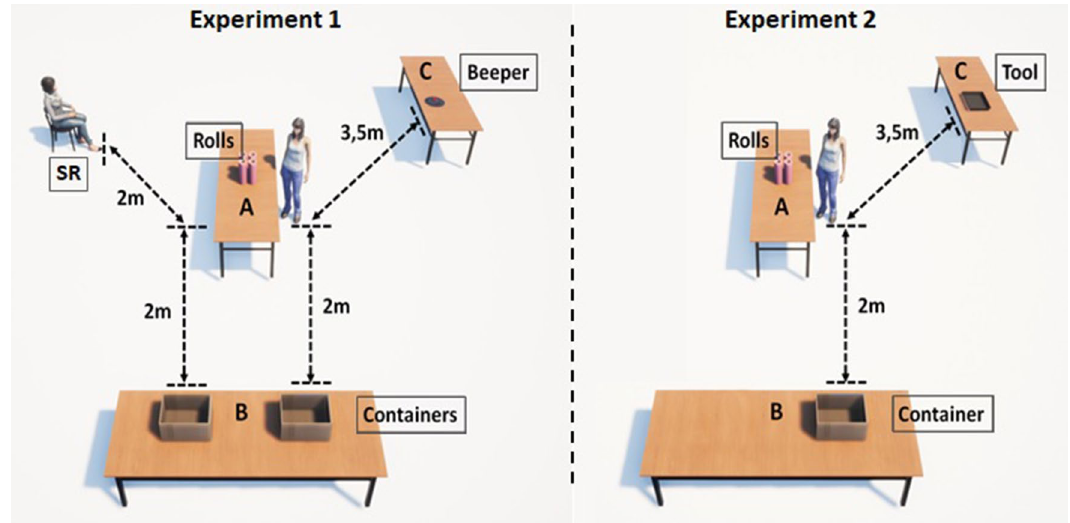
Figure 1. Schematic representation of the design used in Experiments 1 and